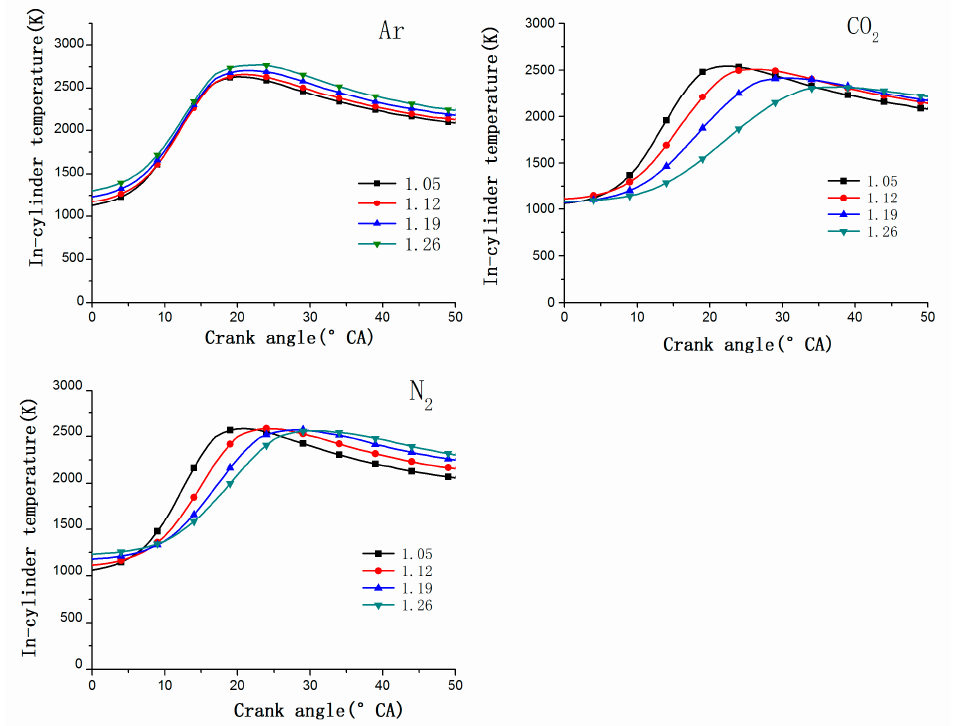
Figure 5. Variation in the cylinder temperature vs. crank angle with the dilution factor (DF) of CO 2 , N 2 and Ar.